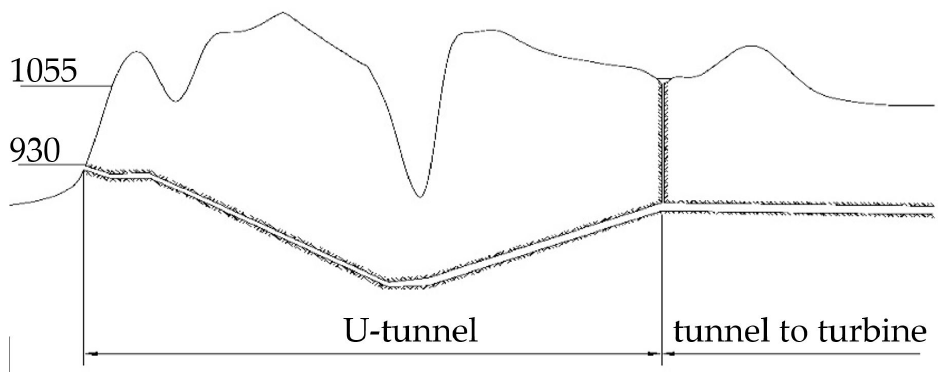
Figure 12. U-tunnel in Saurdal